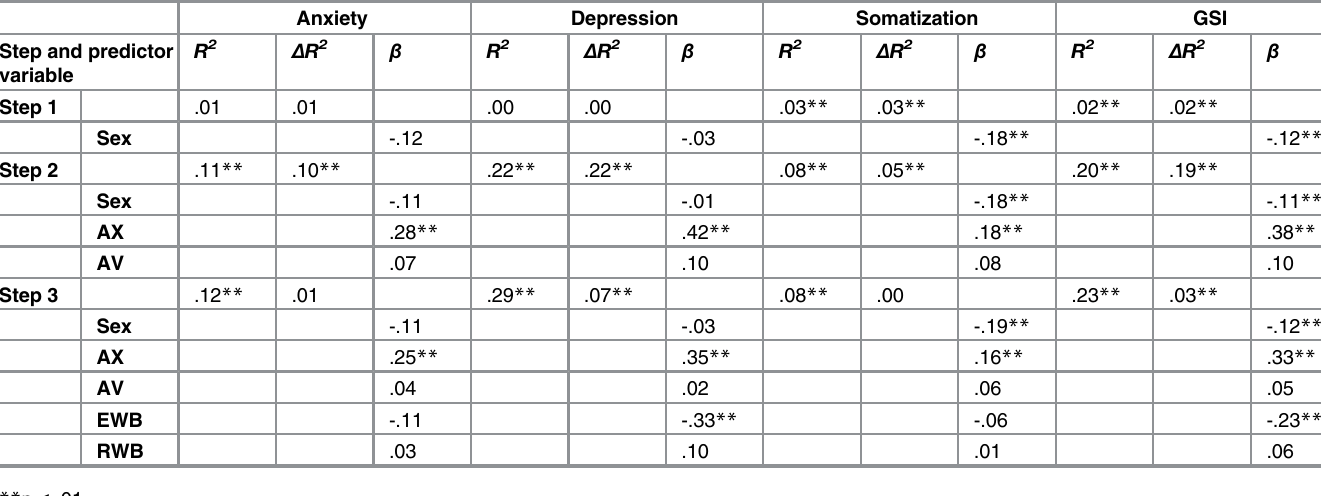
Table 2. Hierarchical regression analyses predicting mood